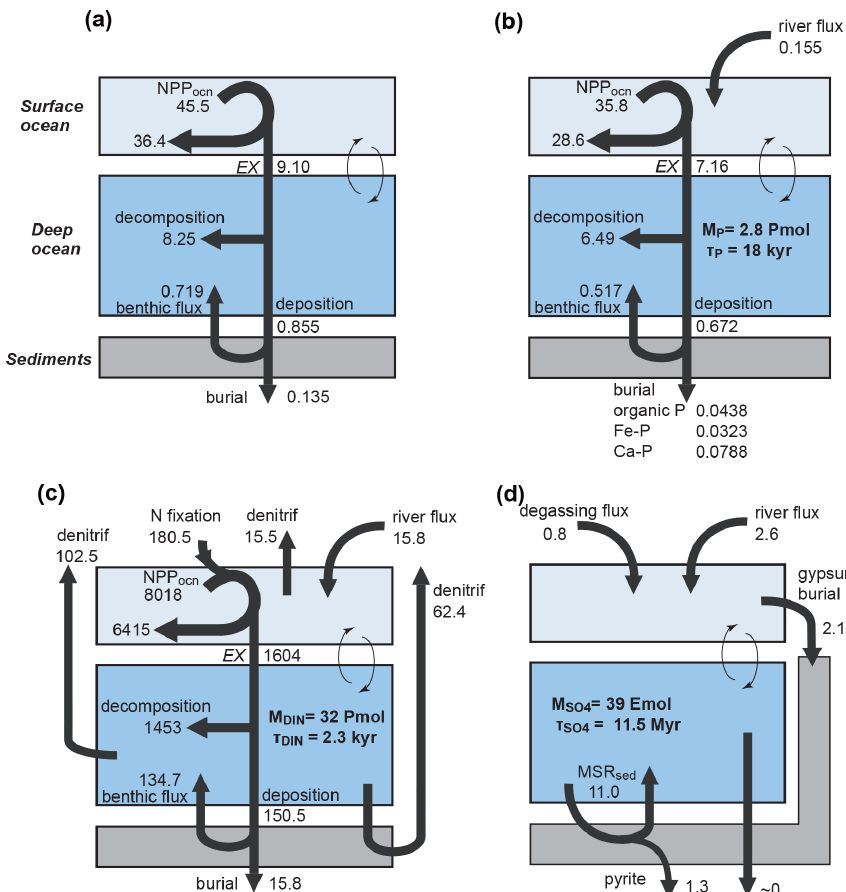
Figure 12. Schematics of the simulated material flow in the ocean for the reference run. (a) Organic carbon (in GtCyr − 1 ), (b) phosphorus (in TmolPyr − 1 ), (c) nitrogen (in TgNyr − 1 ), and (d) sulfur (in TmolSyr − 1 ). NPP ocn is oceanic net primary production. EX represents export production. M X is the mass of X in the ocean. τ X is the residence time of X in the ocean. Pmol stands for 10 15 mol, and Emol stands for 10 18